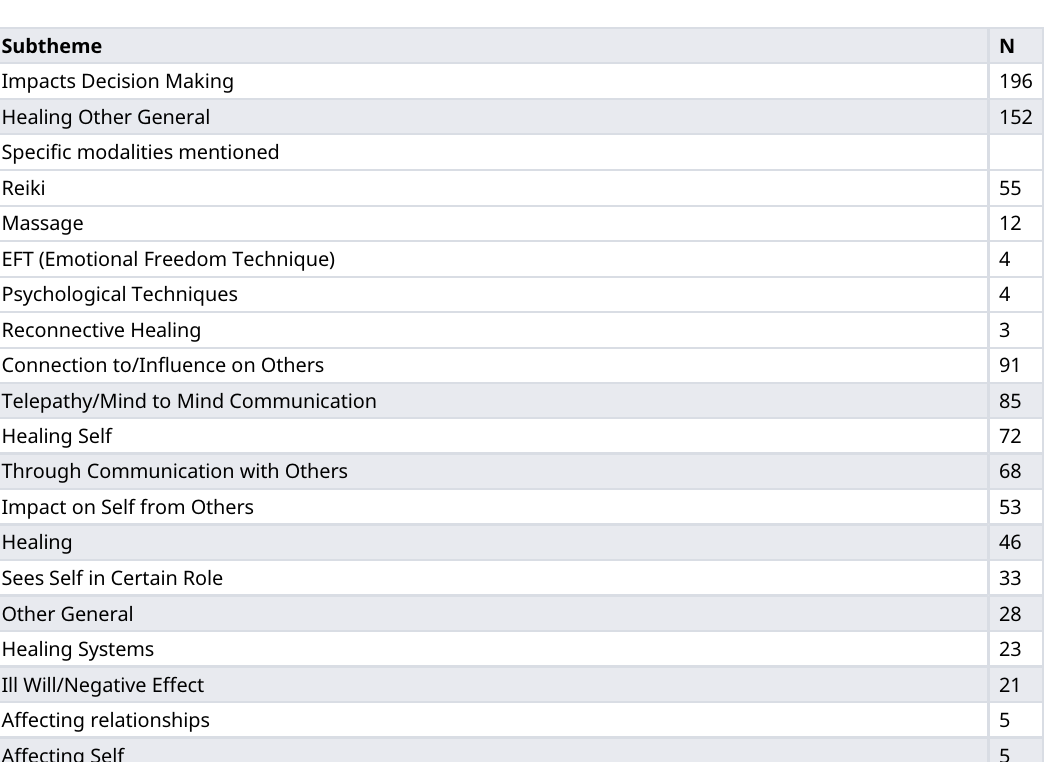
Table 5. Theme 4 Ways of affecting subthemes and code